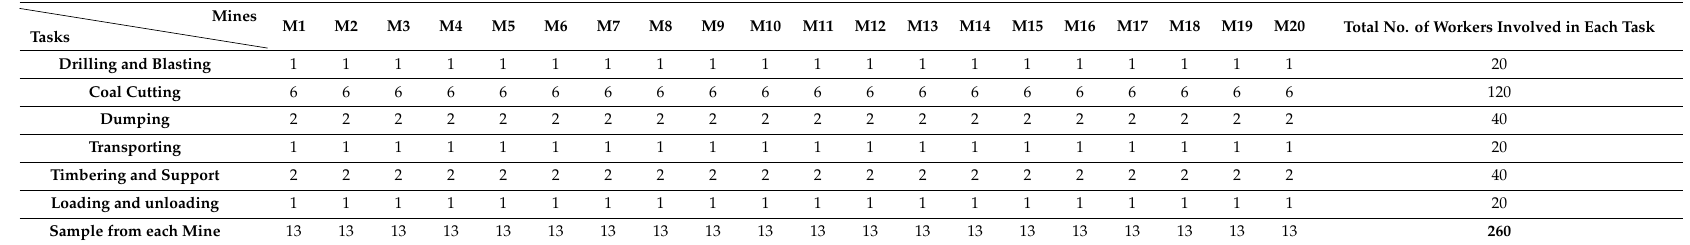
Table 1. Participants selected from each mine and each